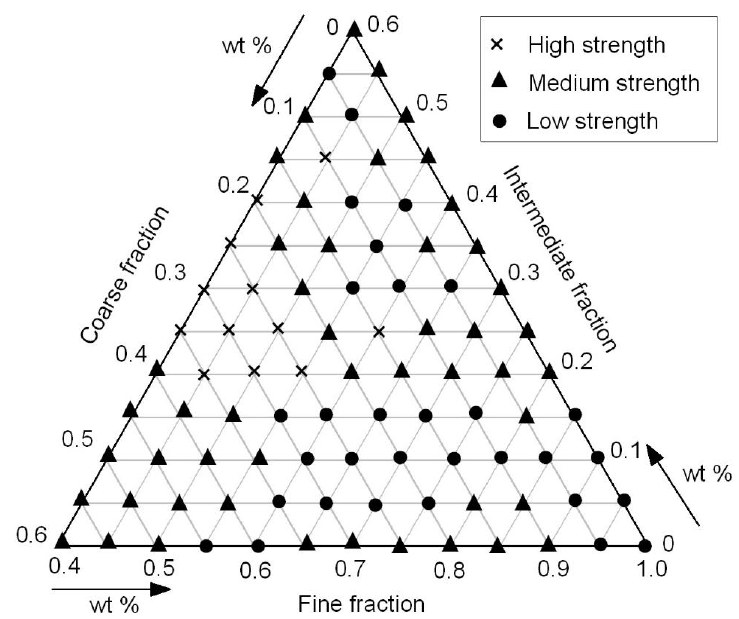
Figure 3. Compressive strength ternary chart of fine, intermediate and coarse fractions.